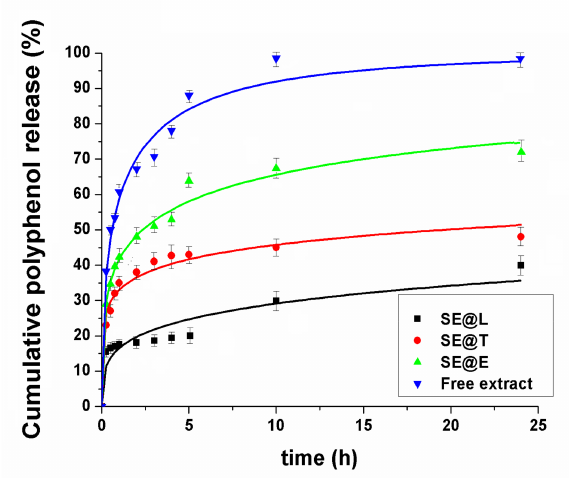
Figure 4. Polyphenols release profiles from SE extract-loaded lipid vesicles in comparison with free SE extract solubilization in PBS of pH 7.4 fitted with the Weibull